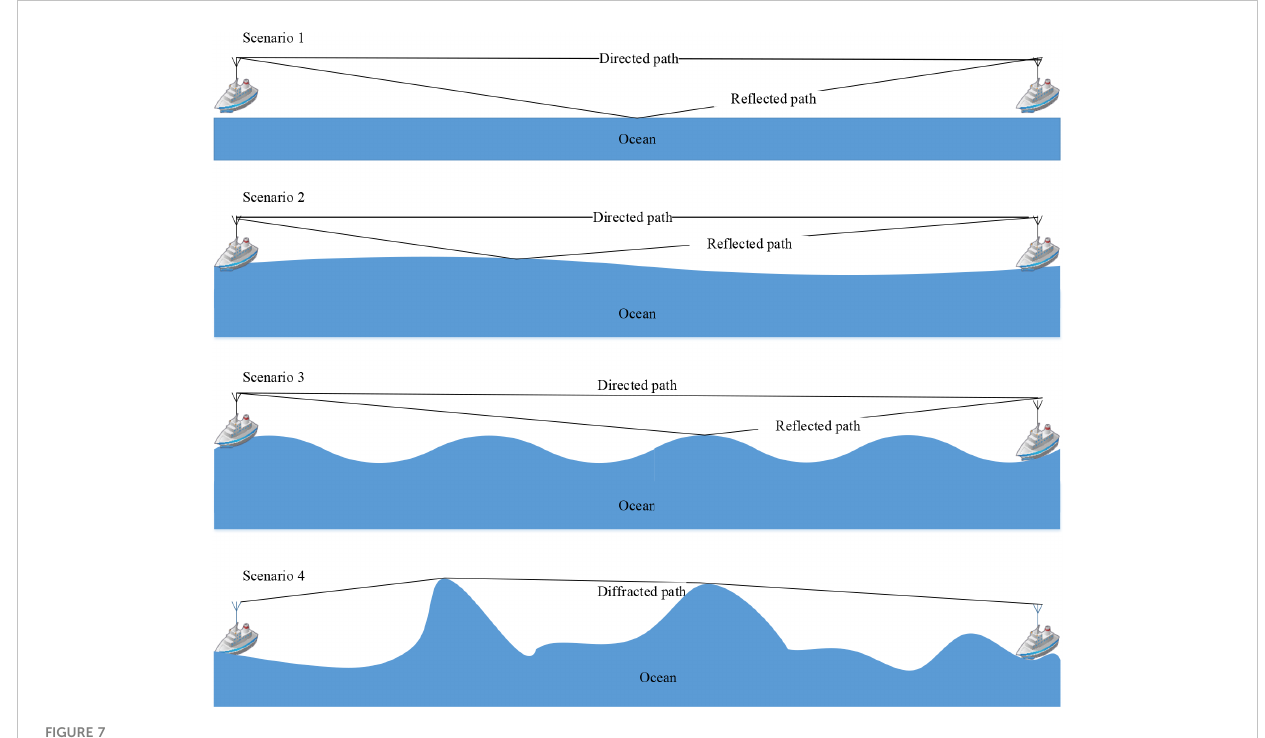
FIGURE 7 Radio propagation mechanisms under different sea surface conditions.